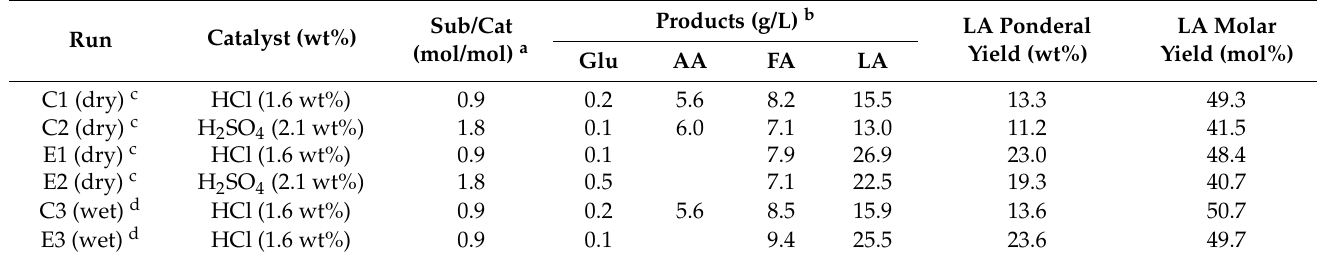
a Substrate to catalyst molar ratio: mol of anhydrous glucose unit in the starting biomass/mol of catalyst; b Glu = glucose; AA = acetic acid; FA = formic acid; LA = levulinic acid; c the sample was used after drying step; d the sample was employed as